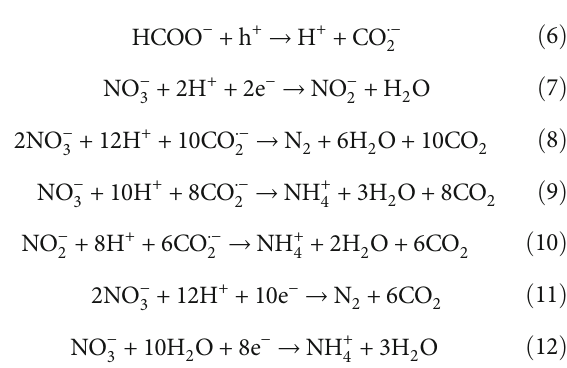
photocatalyst. 2